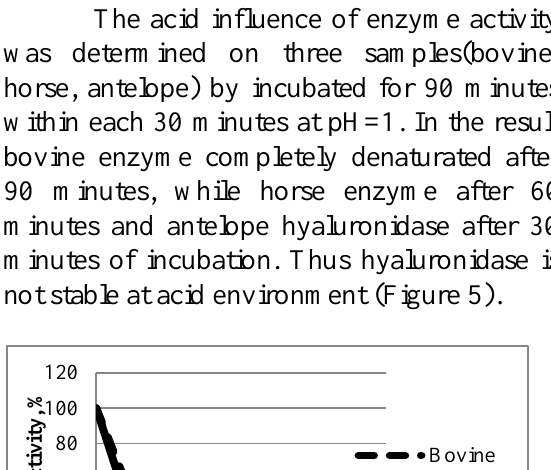
Figure 3. Base influence on enzyme activity